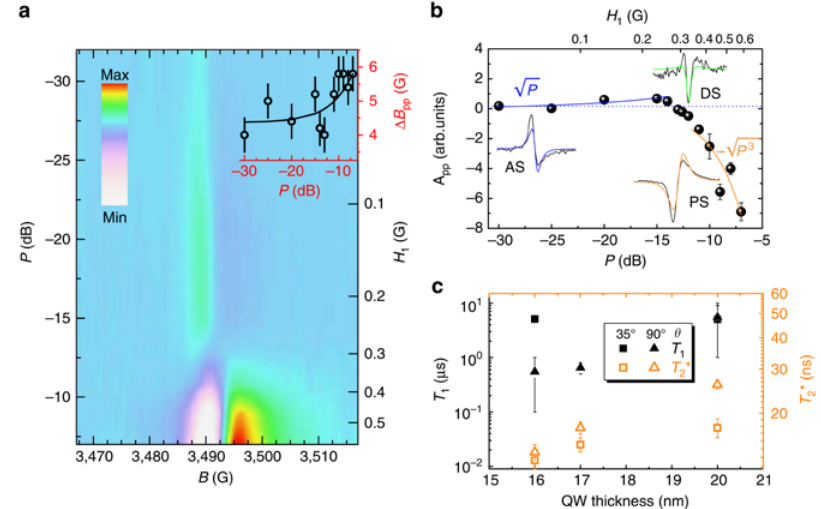
Figure 1. ( a ) Color-coded intensity map of the conduction electron spin resonance peak in 17 nm Ge quantum wells (QWs) as a function of the microwave power ( P ). ( b ) Peak-to-peak amplitude ( A pp ) of the peaks shown in ( a ) versus P . ( c ) Values of spin-lattice relaxation time T 1 and ensemble dephasing time T ∗ obtained from electron spin resonance peaks in QWs with di ff erent thickness. (Reprinted from Reference [6], © (2016) Springer Nature. This article is licensed under a Creative Commons Attribution 4.0 International License http: // creativecommons.org / licenses / by / 4.0 /